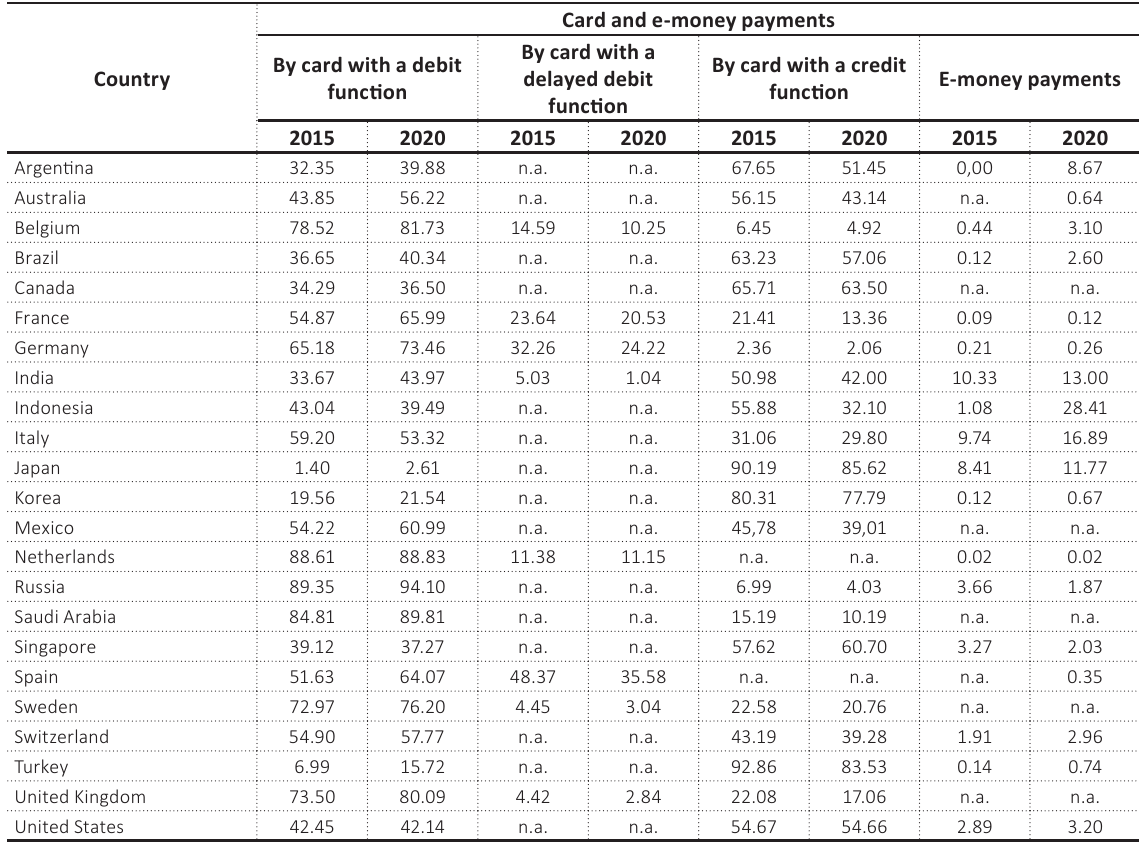
Table 1. Relative importance of e-money payments in selected countries of the world in 2015 and 2020 (in value of card and e-money payments, %) Card and e-money